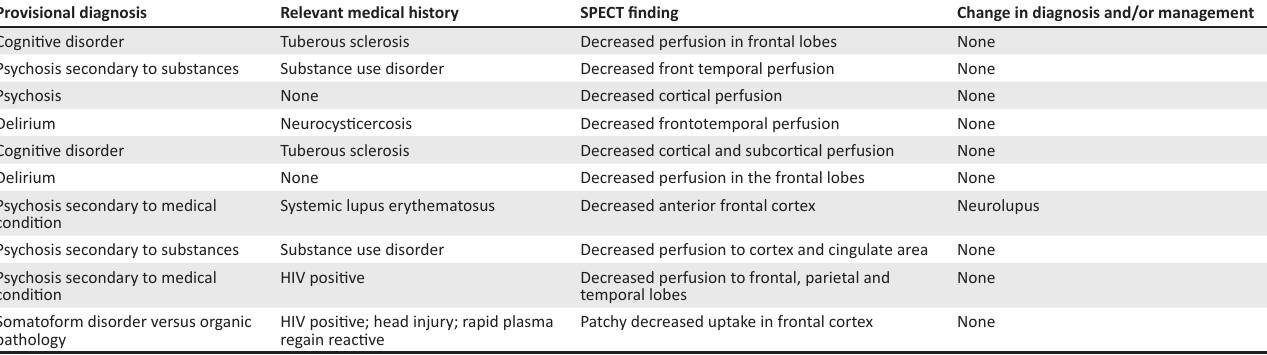
TABLE 5: Clinical features, diagnosis and management of patients with clinically significant single photon emission computed tomography